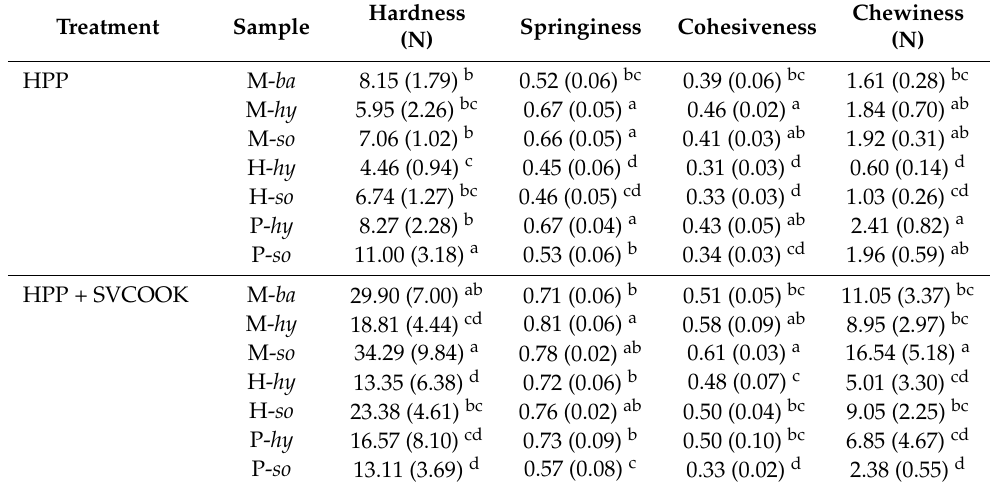
Table 3. Textural parameters of samples treated by HPP or HPP + SVCOOK according to protein matrix (M: meat-based patty; H: hybrid patty; P: plant-based patty) and fat replacement ( ba : backfat; hy : hydro-gelled emulsion; so : soya emulsion). Values are expressed as mean (standard deviation). Chewiness Hardness Springiness Cohesiveness Treatment Sample (N) (N) HPP M-